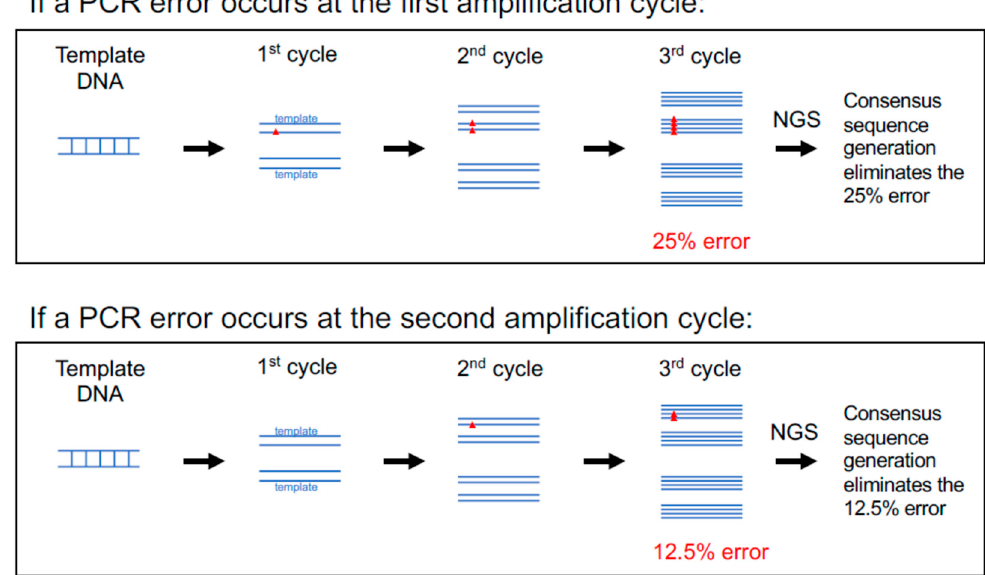
Figure 3. PCR errors are corrected via consensus sequence generation. Errors introduced during the PCR amplification step (red triangles) mainly involve single-base substitution errors at random locations. An error that occurs at an earlier PCR amplification cycle will carry over into a larger proportion within the final amplicon pool (25% if first cycle) relative to an error that occurs at a later amplification cycle (12.5% if second cycle). This figure illustrates that per error introduced, the maximum frequency of representation is 25% within the final amplicon pool, which can be corrected via consensus sequence generation of the deep sequence data.